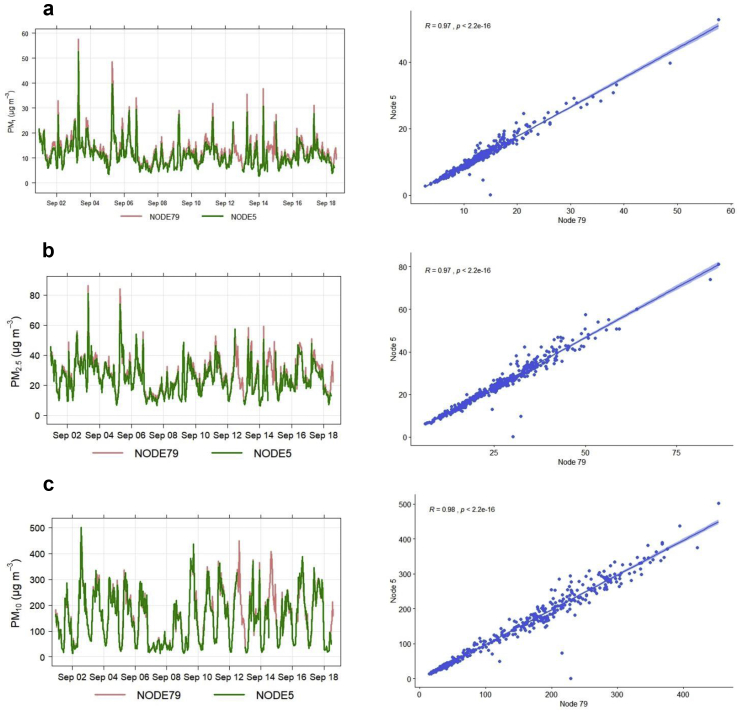
Hourly time series and corresponding Pearson correlation plot of data from Node 79 versus Node 5 at UCC: (a) PM1, (b) PM2.5, and (c) PM10.